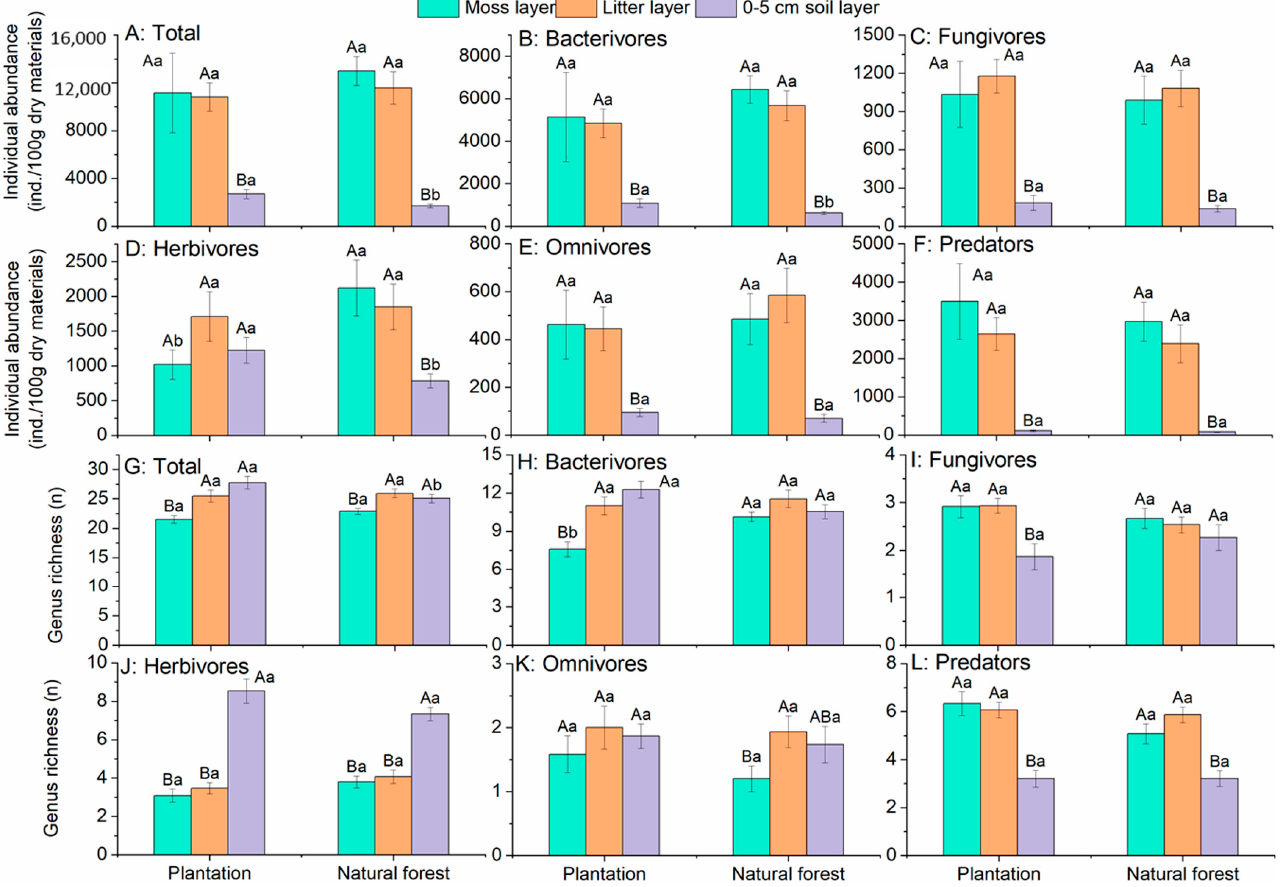
Figure 3. Total and trophic-group nematode individual abundance ( A – F ) and genus richness ( G – L ) in subalpine spruce plantations and natural forests. Upper-case letters indicate significant differences among the three layers (moss, litter, 0–5 cm soil); lower-case letters indicate significant differences between the two forest